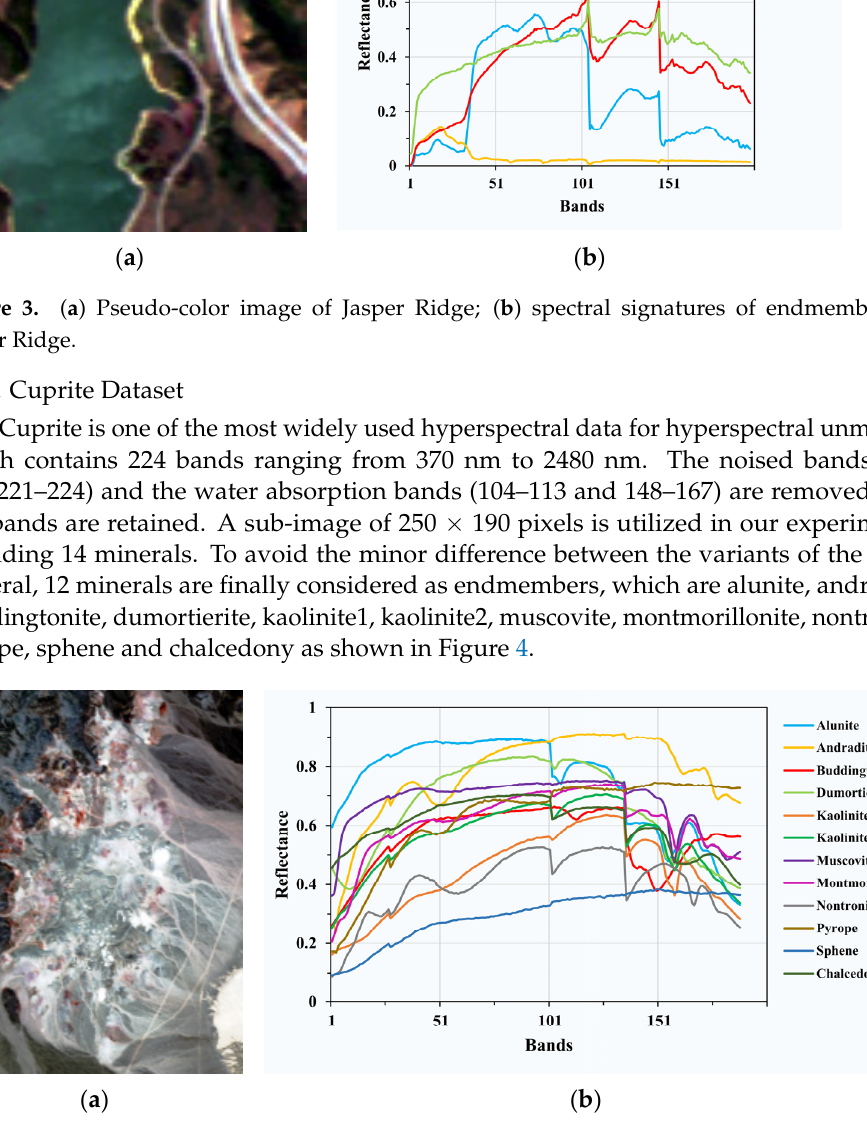
Figure 2. ( a ) Pseudo-color image of Samson; ( b ) spectral signatures of endmembers in Samson.